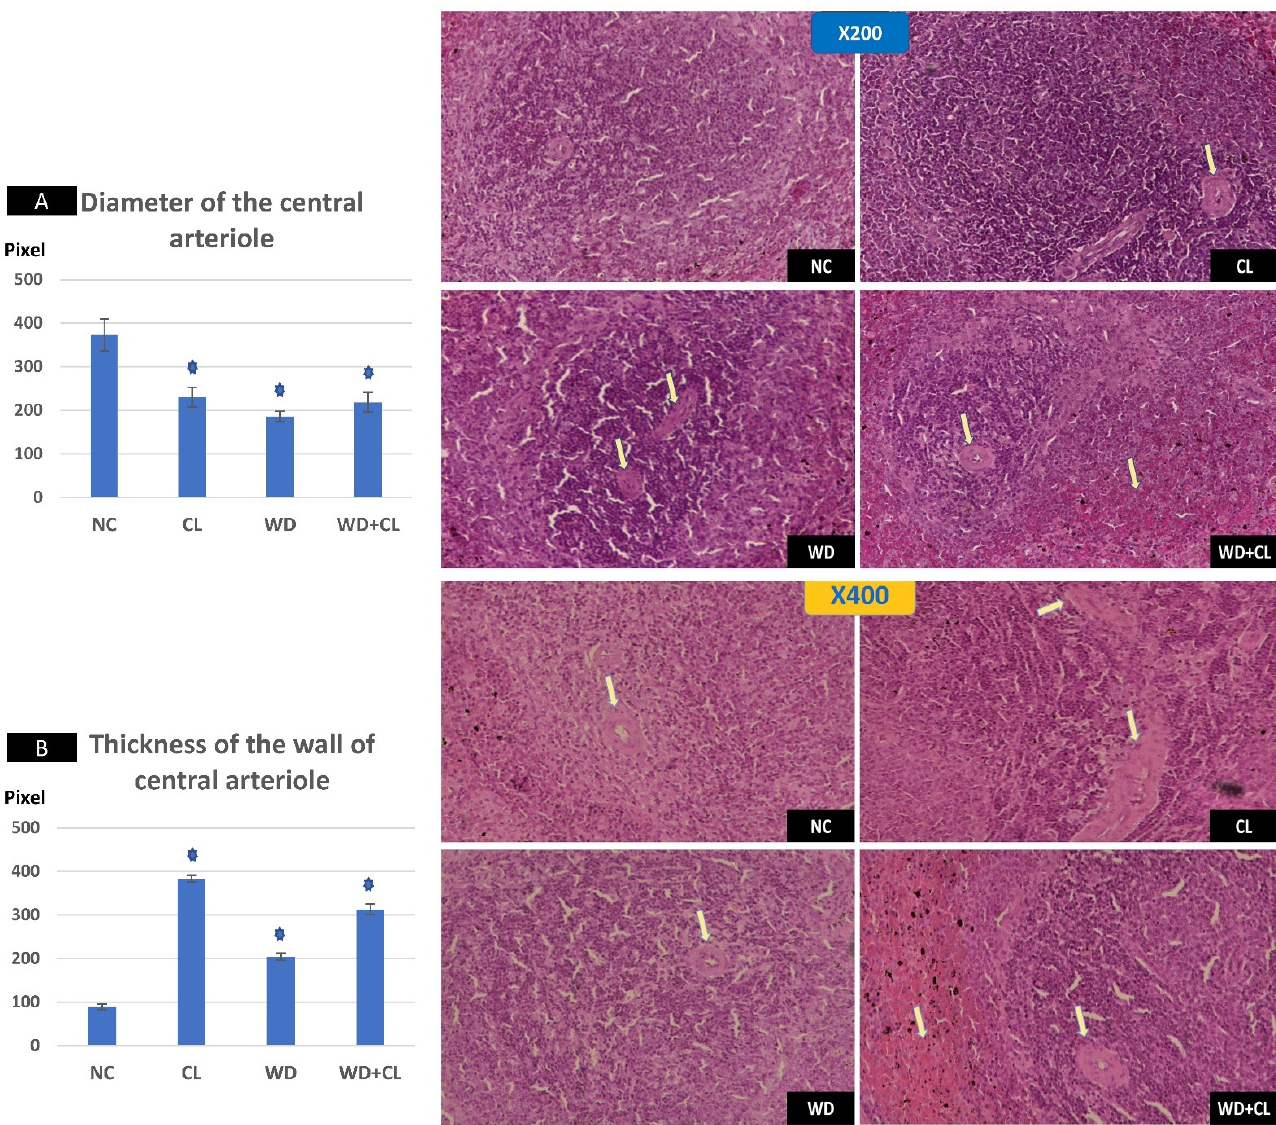
Figure 4. Histopathological changes in the spleen among the study groups at × 200 (above) and × 400 (below). The normal control (NC) section shows normal central arteriole, white pulp, and red pulp. Continuous light (CL) shows a thick-walled and narrow lumened central arteriole (arrow). Western diet (WD) slide shows moderate wall thickening and the narrow lumen of the central arterioles (arrows). Combined WD + CL shows wall thickening and narrow lumen of the central arterioles splenic tissue areas with congestion and hemorrhaging (arrows). Diameter of the central arteriole ( A ) and wall thickness ( B ) were significantly different than the NC group. * p < 0.05.